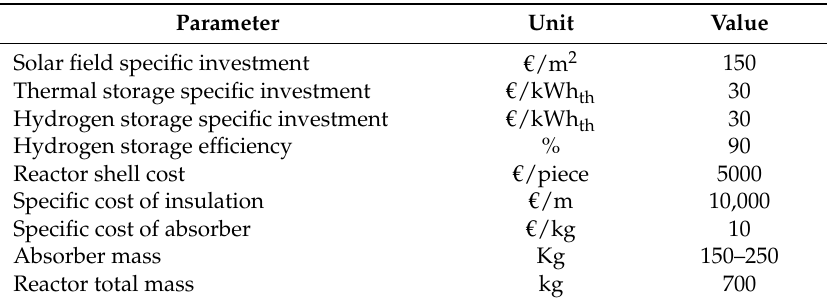
Table 2. Investment assumptions (base case).